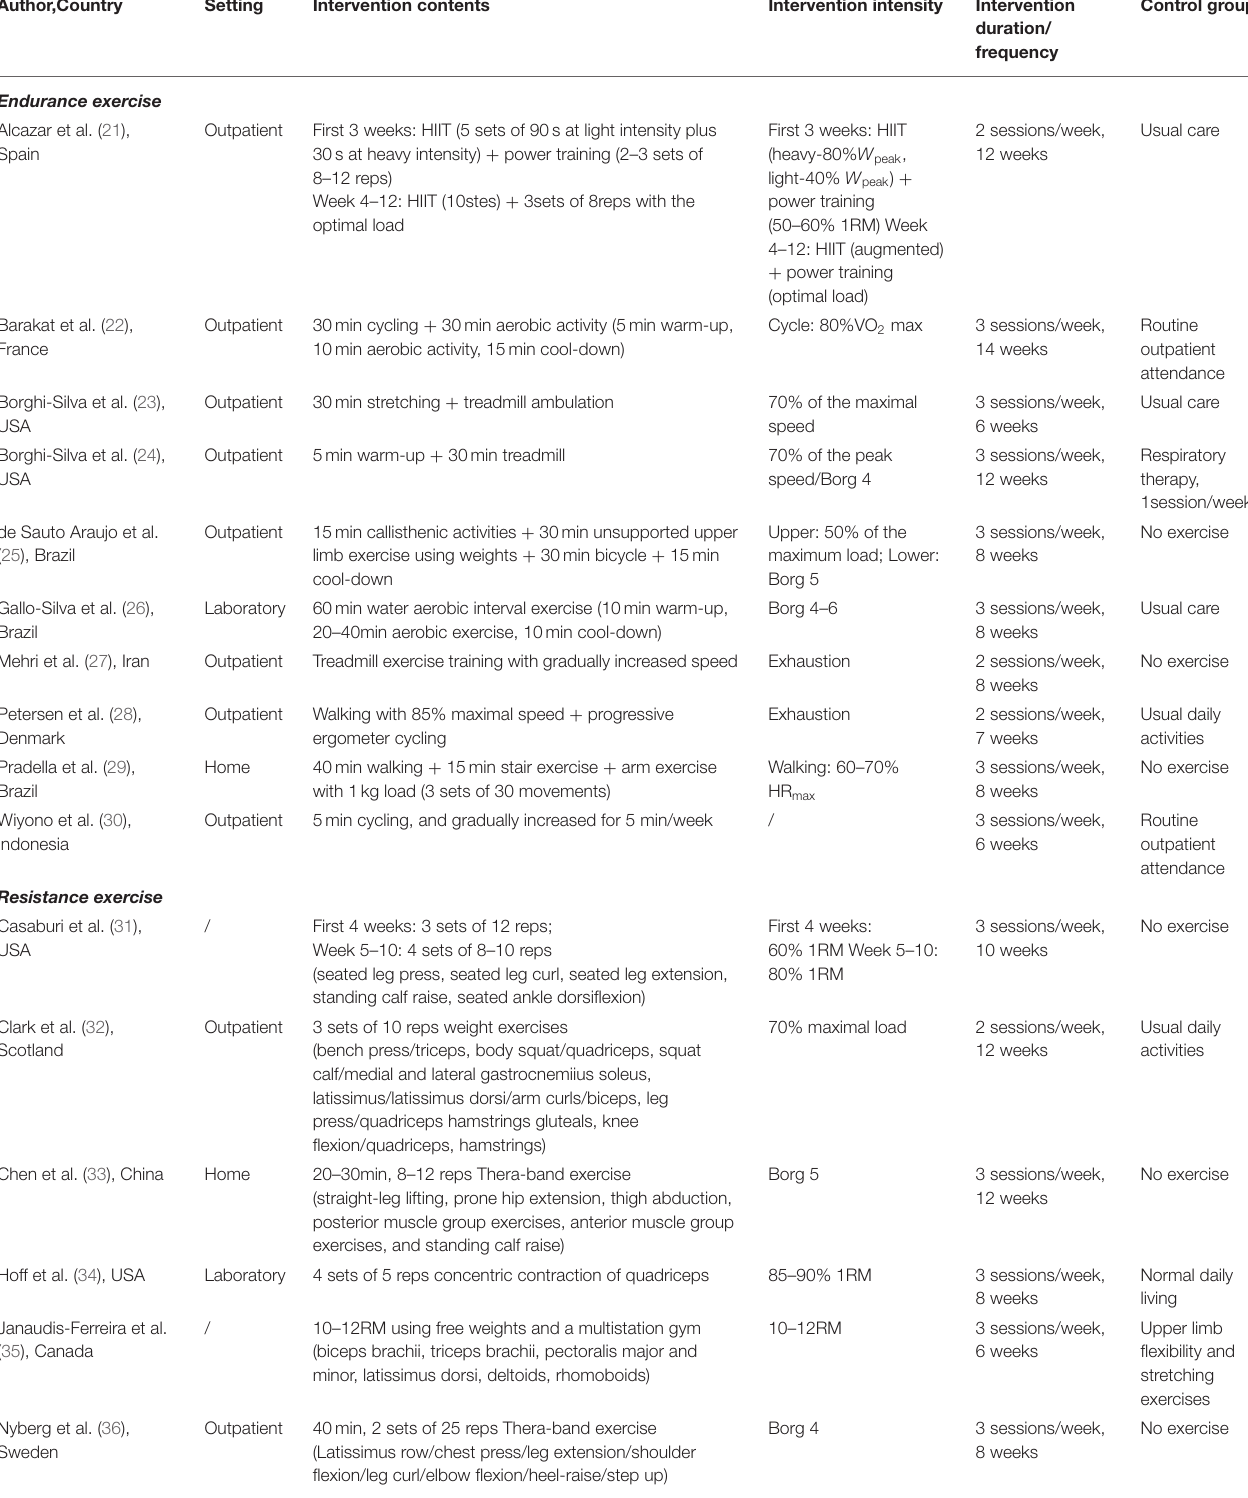
TABLE 2 | Characteristics of intervention